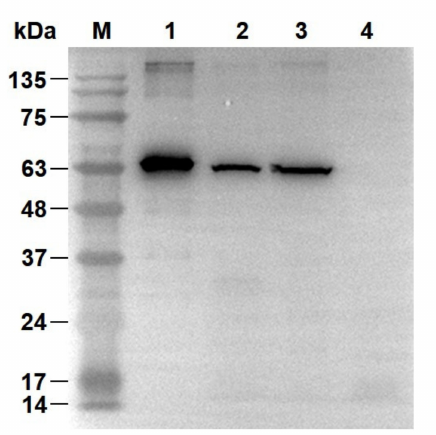
Figure 2. Confirmation of the purified rice black-streaked dwarf virus (RBSDV) His-P10 protein by the anti-P10 protein mAB. Purified RBSDV His-P10 protein (as positive control, Lane 1); membrane (Lane 2) and cytosolic (Lane 3) protein fractions of RBSDV-infected small brown planthopper (SBPH); cytosolic protein fraction of RBSDV-free SBPH (as negative control, Lane